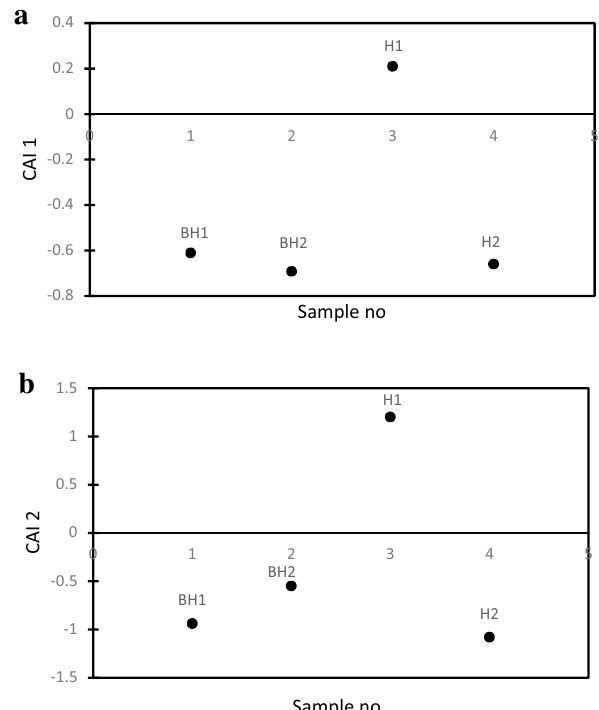
Figure 6. Chloro-Alkaline Index CAI 1 ( a ) and CAI 2 ( b ) for enrichment